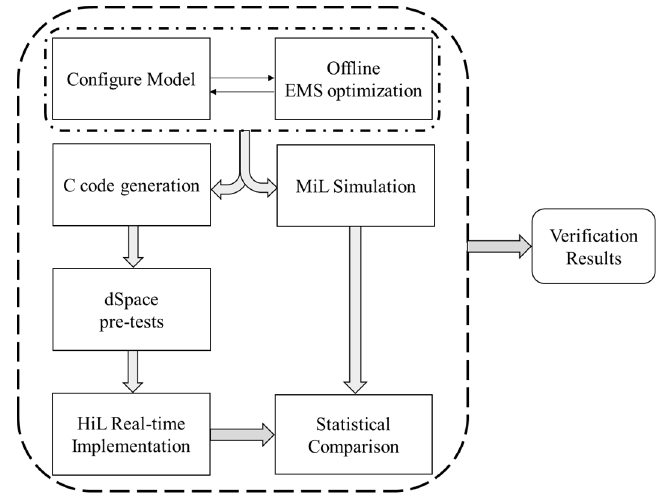
Figure 11. Study procedure of hardware-in-the-loop (HiL) vs. model-in-the-loop (MiL) verification.